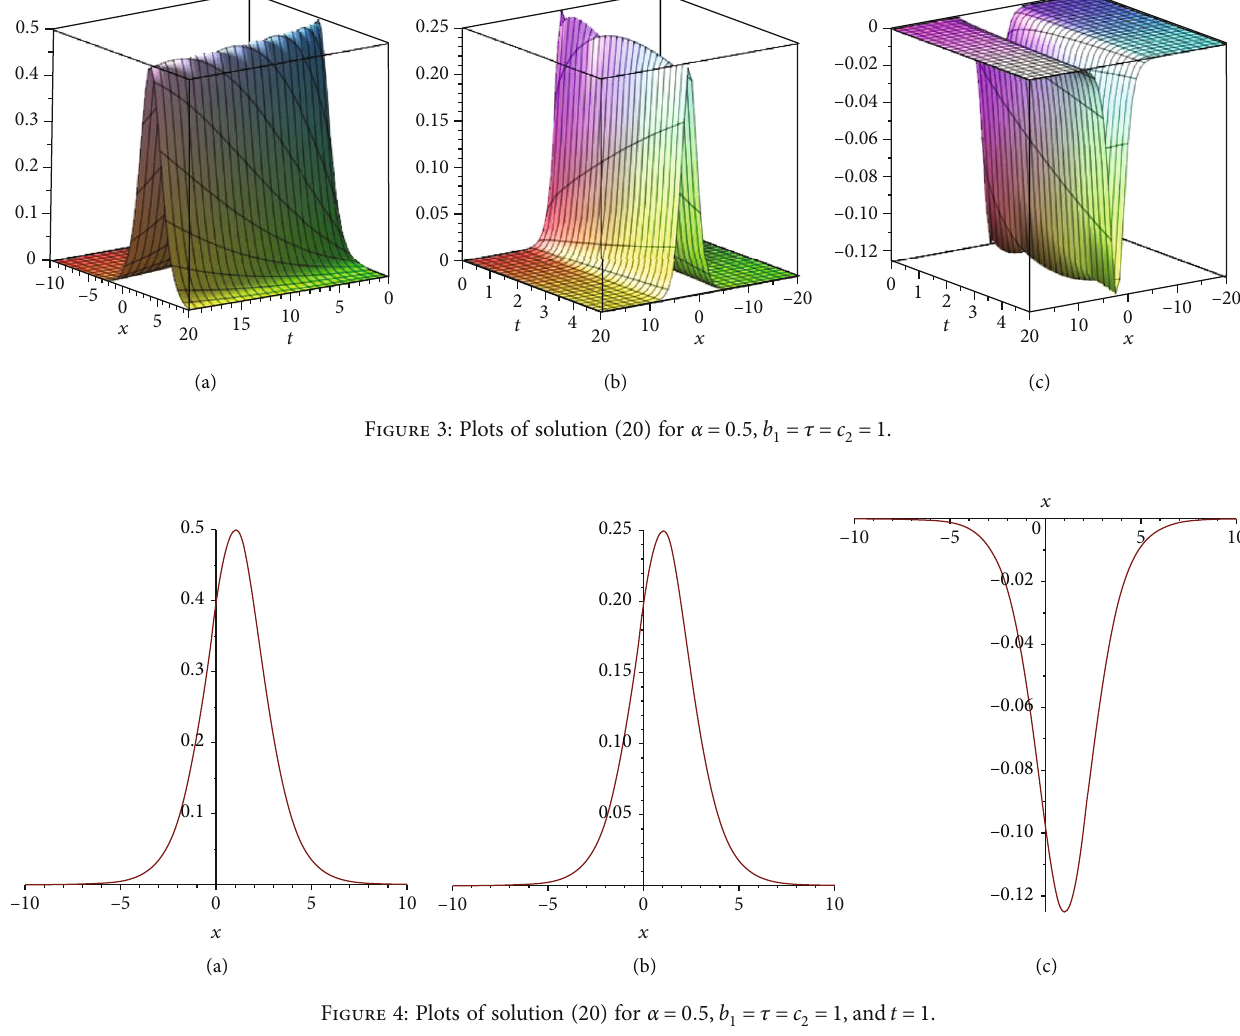
Figure 4: Plots of solution (20) for α = 0 : 5, b